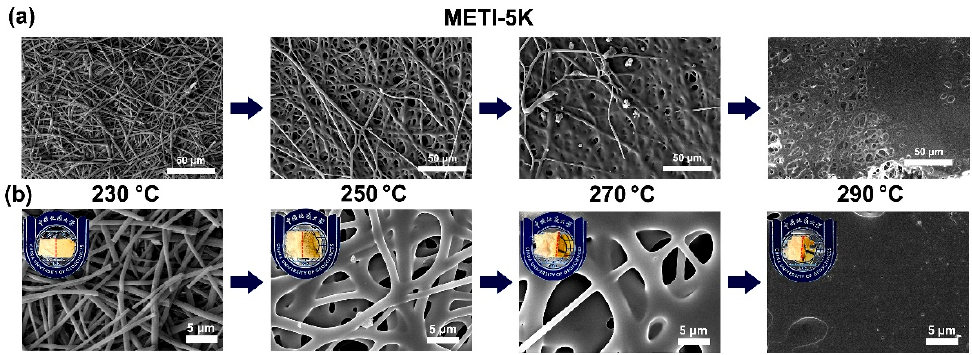
Figure 9. SEM images of METI-5K NFM after hot-pressing treatment. ( a ) 500×; ( b ) 4000×.